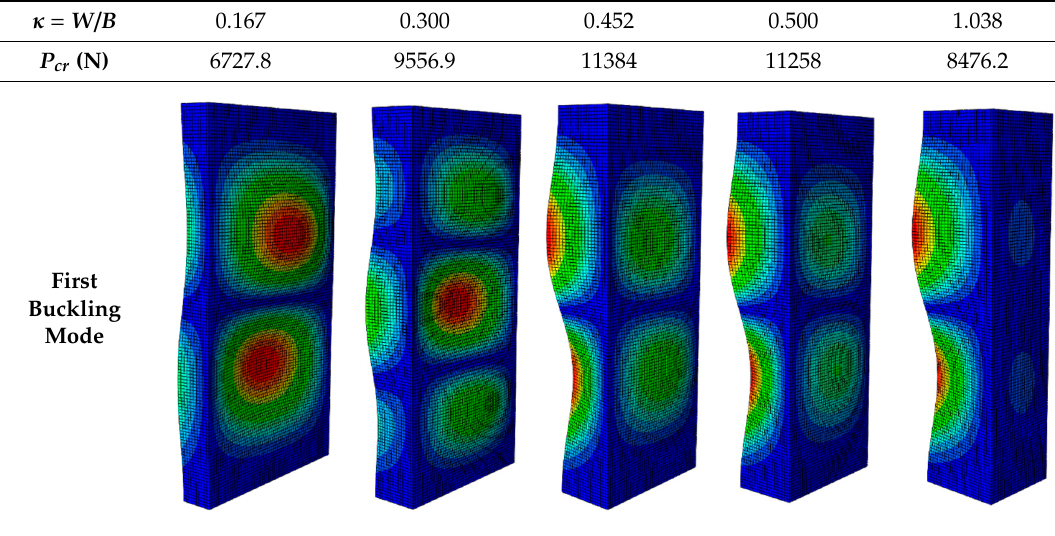
Table 4. First Buckling Modes of the Strut with Different Flange/web Dimension Ratios.